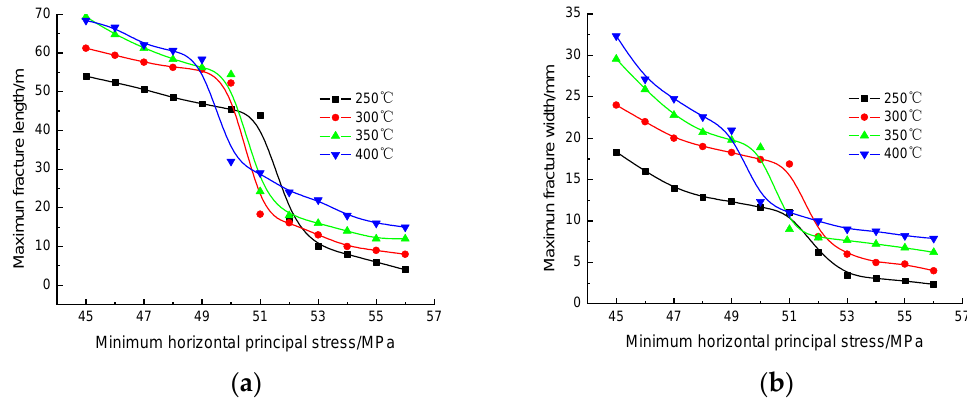
Figure 11. The relation between fracture length and width and horizontal minimum principal stress. ( a ) Fracture length curves. ( b ) Fracture width curves.